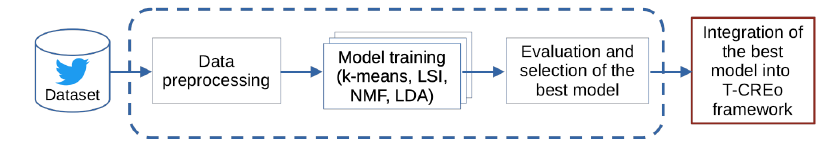
Figure 3. Diagram of the comparative evaluation phase.